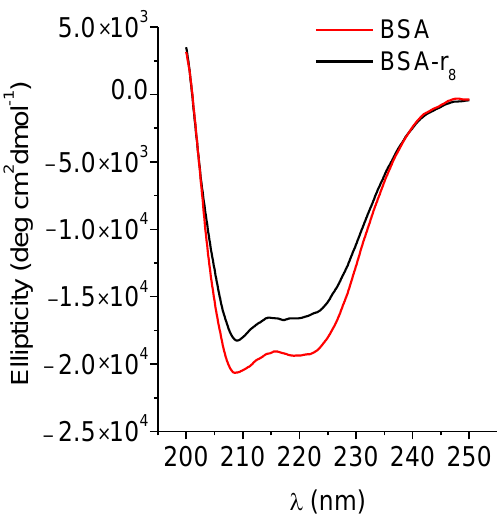
Figure 1. Circular dichroism spectrum of BSA before and after r 8 functionalization. DOL: 2.4 r 8 /BSA. BSA and BSA-r 8 1.5 × 10 −5 M samples were prepared in PBS.